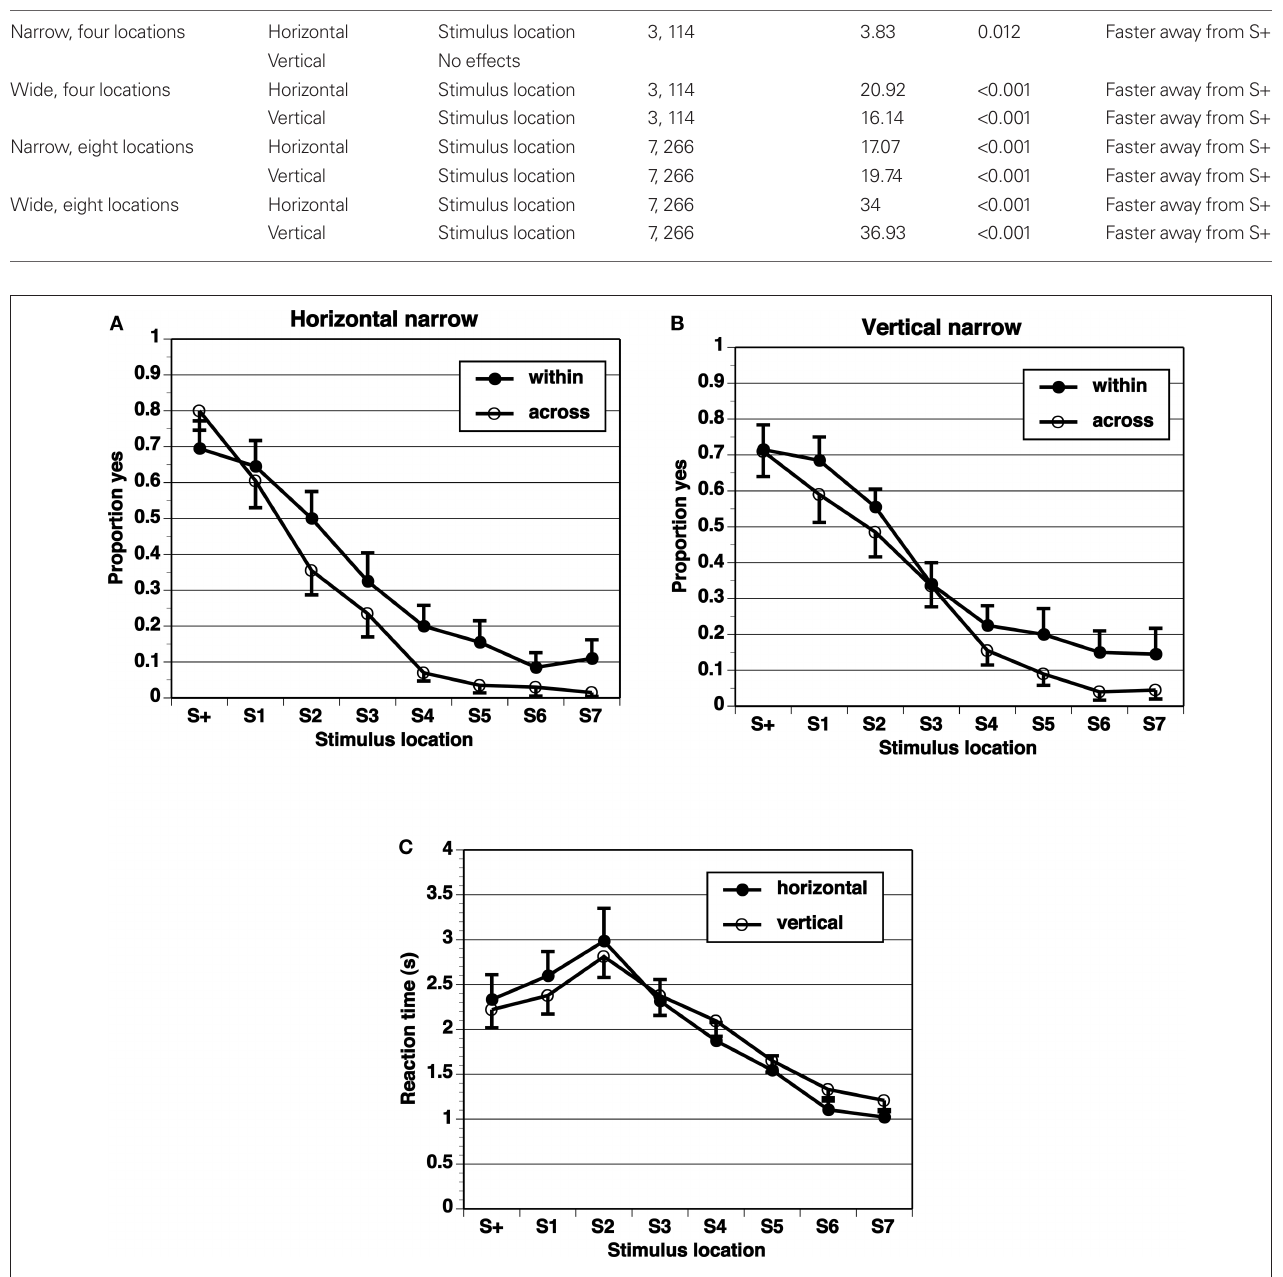
Figure 4 | Proportion of “yes” responses (A, B, M ± SeM) and reaction times (C, M ± SeM) in Narrow-8 experiment, with narrow spacing between stimulus locations and eight test locations.